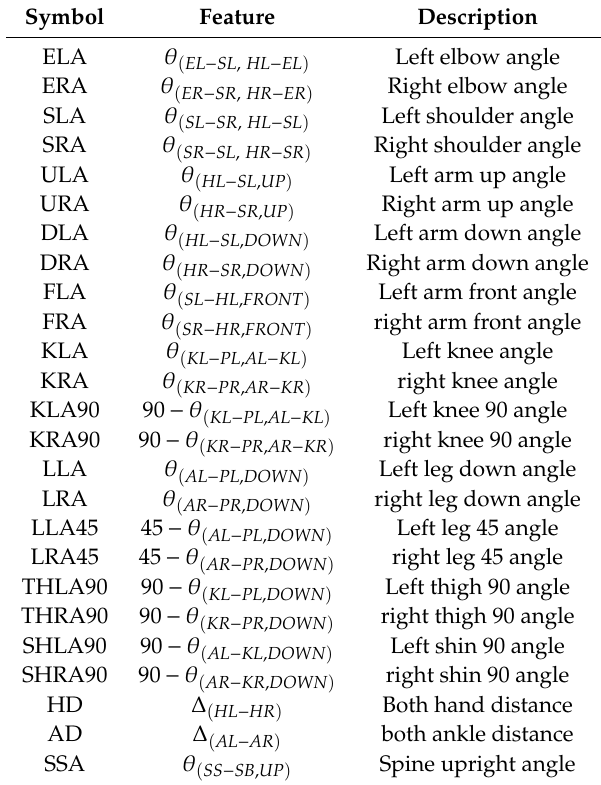
Table 1. Twenty-five Features for Exercise Posture Recognition